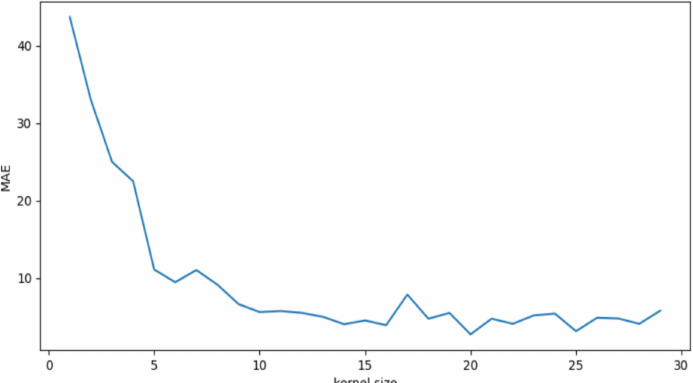
Figure 6. MAE under different kernel sizes.